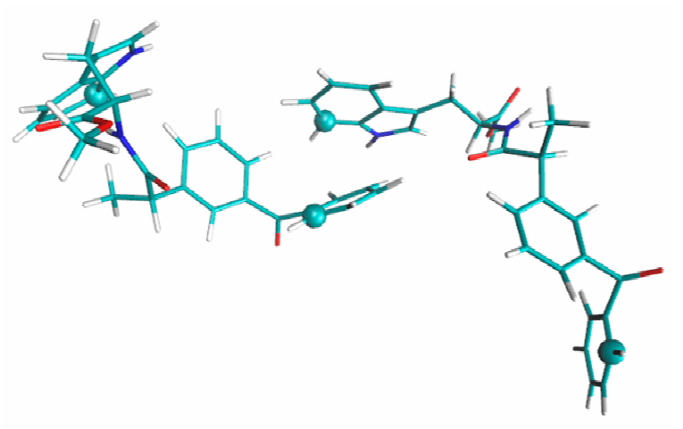
Figure 5. The approach of two molecules of ( R,S )-diastereomer of dyad II, forming a dimer. The distance between atoms marked by spheres was analyzed [20].